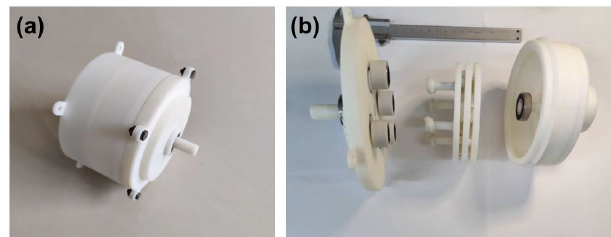
Figure 3. Reducer model. (a) Overall model of reducer and (b) ex- ploded view of model.